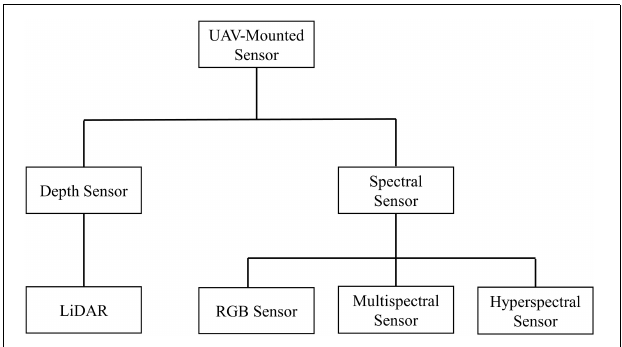
FIGURE 2 | UAV-mounted sensor